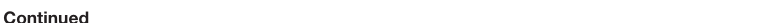
FIGURE 1 | Continued recording. The mean value with error bar ( ± SEM) is indicated for each sample ( n = 6 for VdTRPA1L and n = 4 for mock-transfected and VdTRPA1S). p -value for VdTRPA1L-expressing cells compared to mock-transfected cells is < 0.04 (*). (D) The representative trace indicates the activation currents of VdTRPA1L elicited by two different heat applications, 16–42 ◦ C (the first stimulation) and 24–42 ◦ C (the second stimulation). The red dotted lines show the apparent initiation points of the currents. The upper and lower traces show the changes of inward current and the changes of bath temperature by time. (E) Arrhenius plots for the heat-evoked VdTRPA1L currents shown in (D) . Blue and black lines represent the current amplitudes generated by heat stimulation from 16 ◦ C (Cold to heat) to 24 ◦ C (RT to heat), respectively. (F) Current–voltage relationship of heat (red line)-, 0.5mM α -terpineol (black line)-, or 0.1mM carvacrol (blue line)-evoked current exhibits a positive reversal potential. We corrected the liquid junction potential ( 1 JPH) between extracellular and intracellular solution but not the heat-dependent shifts of 1 JPH in the